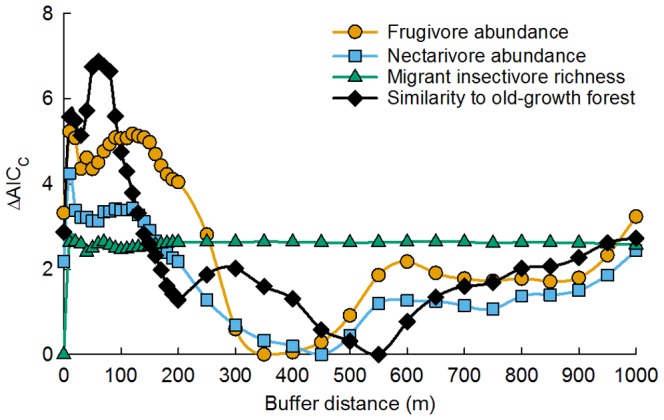
Landscape tree cover model comparison.Model comparison for community similarity to old-growth forest (diamonds) and foraging guilds (frugivores  =  circles; nectarivores  =  squares; migrant insectivores  =  triangles) predicted by tree cover at varying buffer distances around restoration sites. AICc represents an Akaike Information Criterion score corrected for small sample sizes. ΔAICc represents the difference in AICc scores between a given model and the model with the lowest AICc.